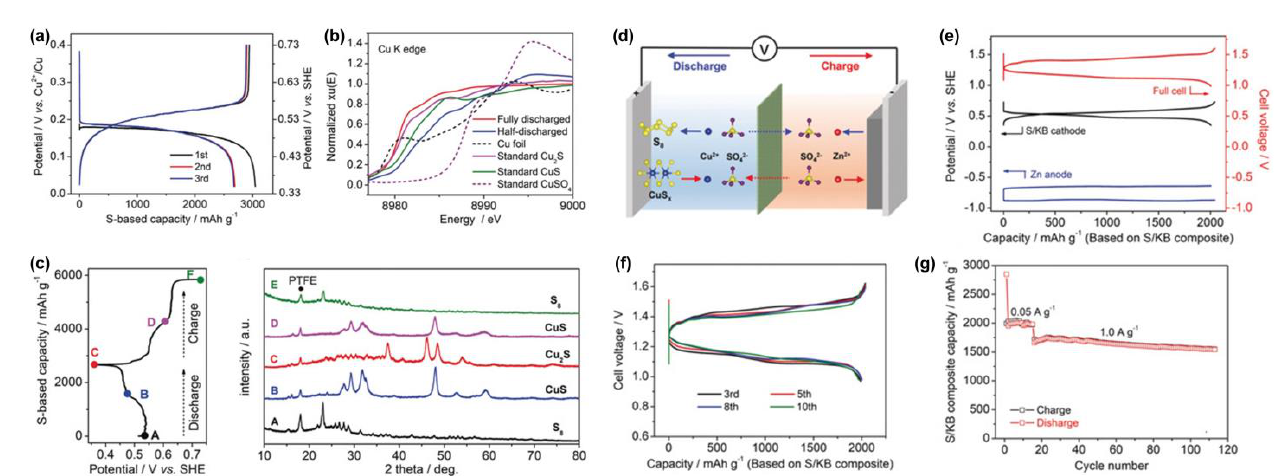
Figure 5. ( a ) GCD curves of the S cathode in a three-electrode cell at 100 mA g −1 ; ( b ) XANES spectra of the Cu-K edge; ( c ) GCD curve at 10 mA g −1 and corresponding ex situ XRD patterns; ( d ) illustration of the mechanism; ( e ) GCD curves of the S cathode, Zn anode, and corresponding hybrid cell; ( f ) GCD curves at 50 mA g −1 and ( g ) cycling performance of the hybrid cell (reproduced with permission from Ref. [67]. Copyright 2019, Wiley-VCH).